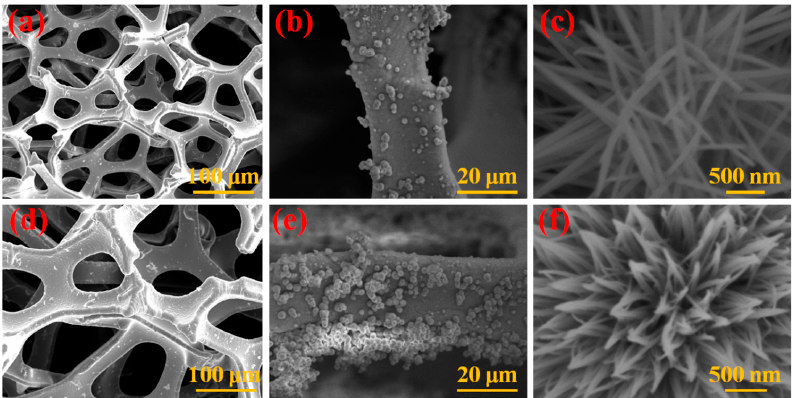
Figure 2. Low- and high-magnification FE-SEM images of the ( a – c ) NiCoO x @NF nanowires; ( d – f ) Fe-dopant@NiCoO x @NF nanoneedle composite. TEM was used to study the microstructure of the as-developed unique composites . It can be clearly identified in Figure 3a,b that the formation of individual particles is ex- plicit and is similar to that found in FE-SEM, with regular particles 3–5 μ m in size whose diameters were around 30 to 50 nm. Impressively, these nanoparticles can be at- tributed to many uniform crystals, resulting in their mesoporous behavior. Therefore, the TEM results are in agreement with the SEM outcomes. The hierarchical and novel NiCoO x @NF nanowire microstructures and their successive ornamentation using Fe-dopant nanosheets could boost the electrical kinetics and the active sites. The selected area electron diffraction (SAED) image (shown in the inset of Figure 3b) displays multi- ple diffraction rings with varied diameters that are indexed with the (220), (311), and (400) phases of the NiCo 2 O 4 spinel [25]. The SAED results reveal the polycrystalline characteristics of the sample. To further distinguish the elemental distributions found in the synthesized Fe-doped@NiCoO x @NF nanosheets, EDS maps were also created, as demonstrated in Figure 3c–g. EDS mappings of the sample showed that Fe, Ni, Co, and O elements uniformly covered the entire nanoneedle, indicating that Fe-dopant particles were successively decorated on NiCoO x .